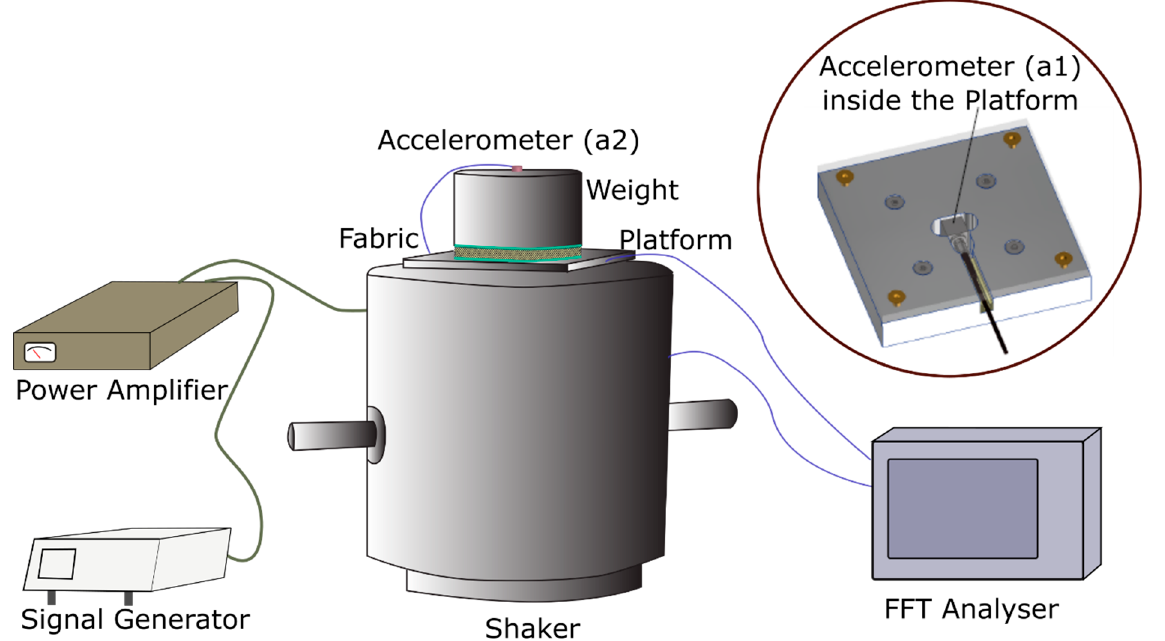
Figure 1. Set-up to evaluate vibration transmissibility of spacer fabrics.